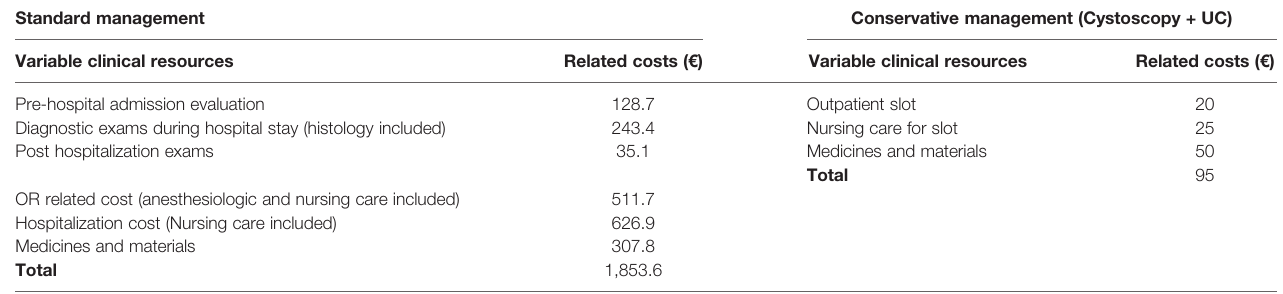
TABLE 4 | Resource consumption and related cost